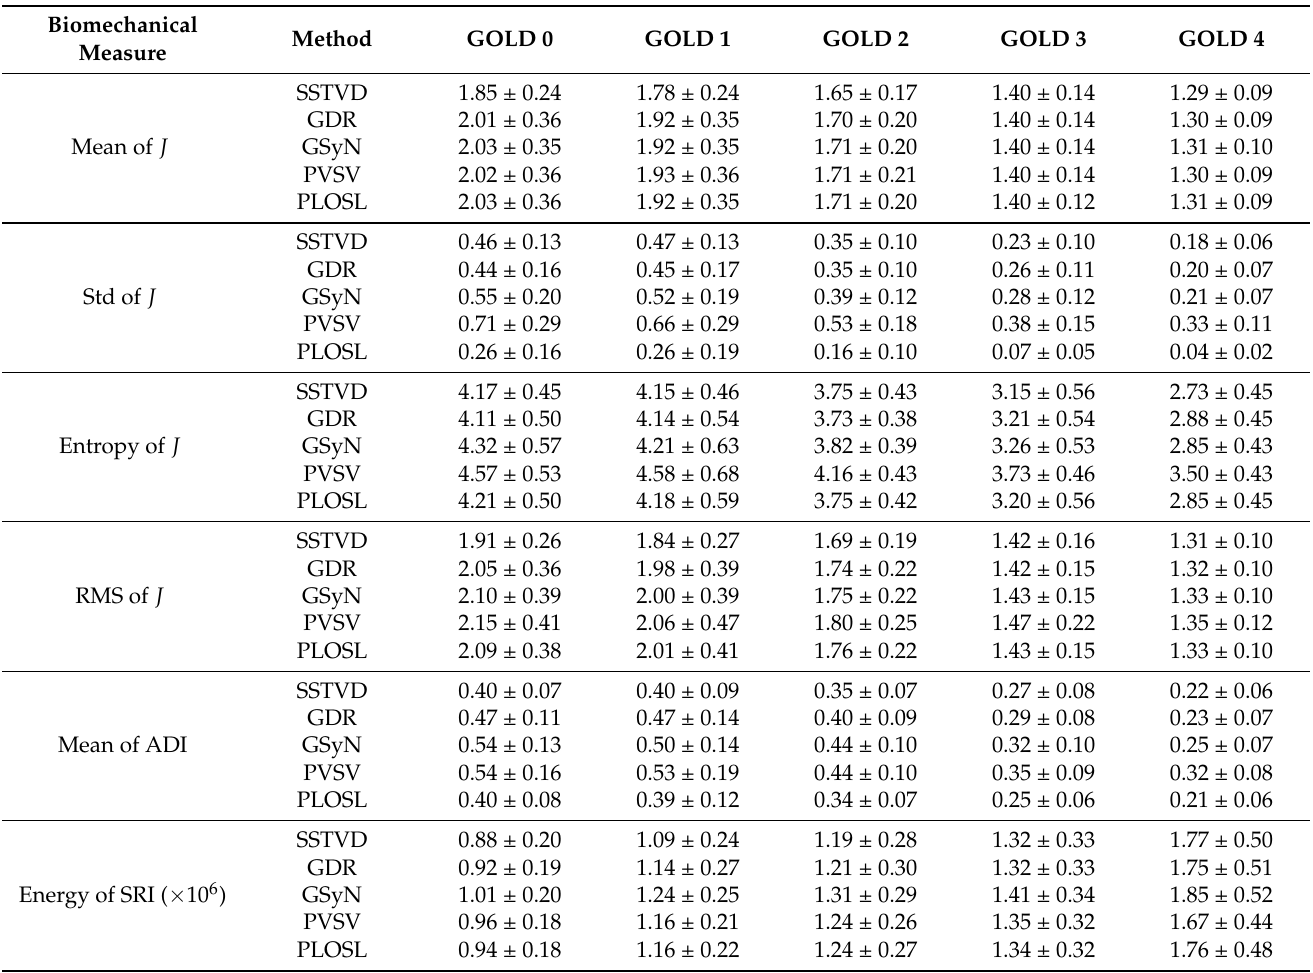
Table A1. Quantitative Results for Figure 4. Comparison of biomechanical measures across image registration algorithms as a function of GOLD stages. Results are provided in mean ± standard deviation